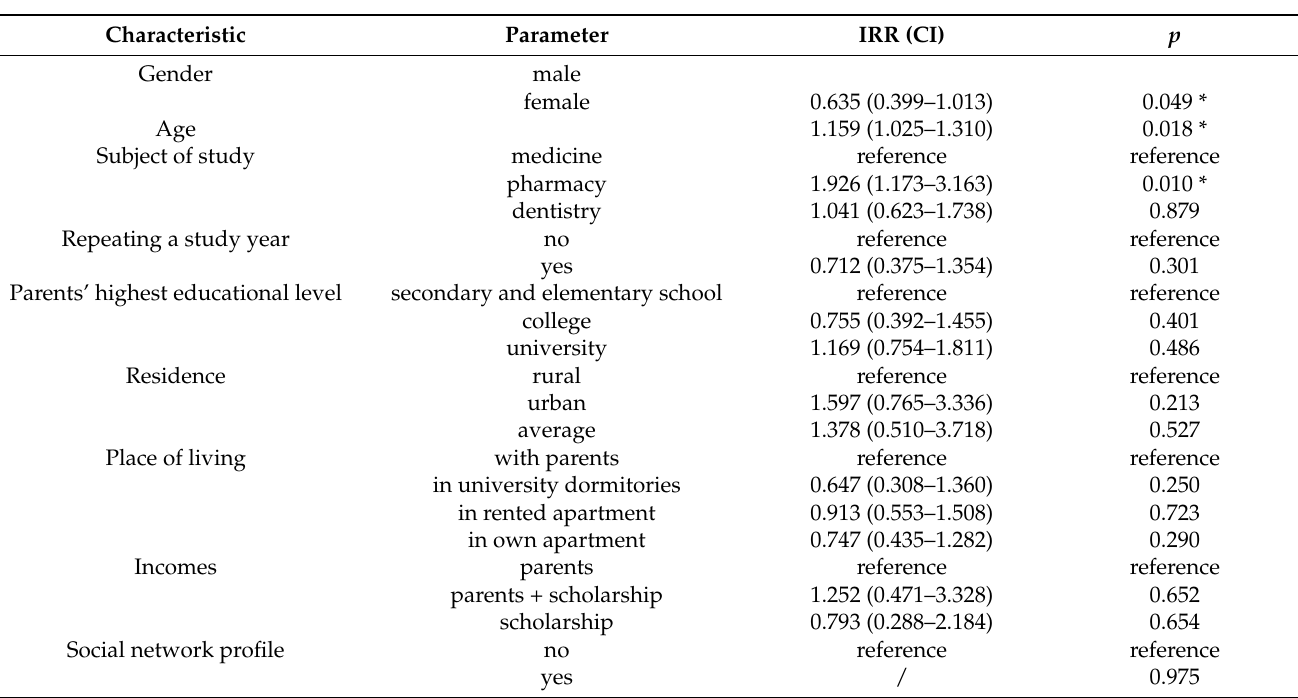
Table 4. Socio-demographic and academic characteristics as predictors of NPS awareness among Serbian future HCPs—negative binomial model ( p -value) and incidence rate ratios (IRR) with 95% confidence intervals